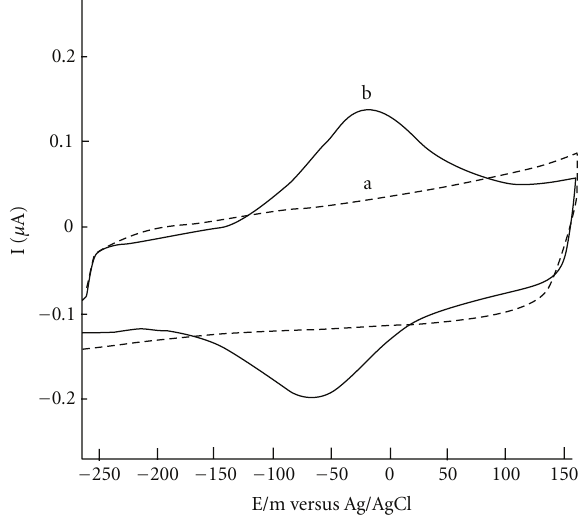
Figure 4: Cyclic voltammograms, using (a) bare glassy carbon electrode in 0.1 M phosphate bu ff er solution and (b) Hb/Mn 2 O 3 - Ag nanofibers/glassy carbon electrode in 0.1M phosphate bu ff er solution (scanrate: 100 mVs − 1